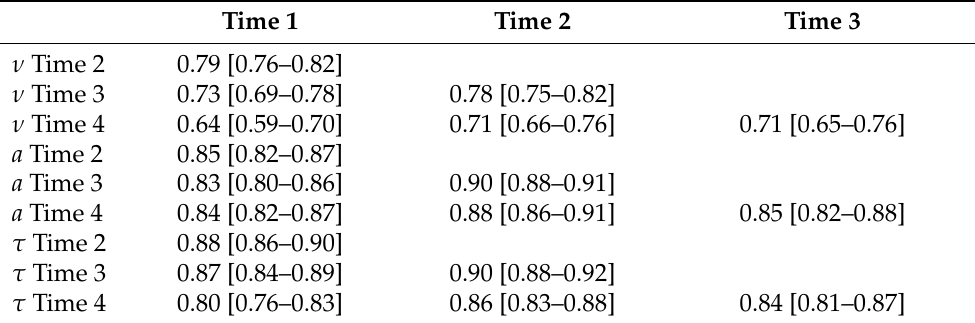
Table 2. Correlation matrices of diffusion model parameters across four time points across all participants. Time 1 Time 2 Time